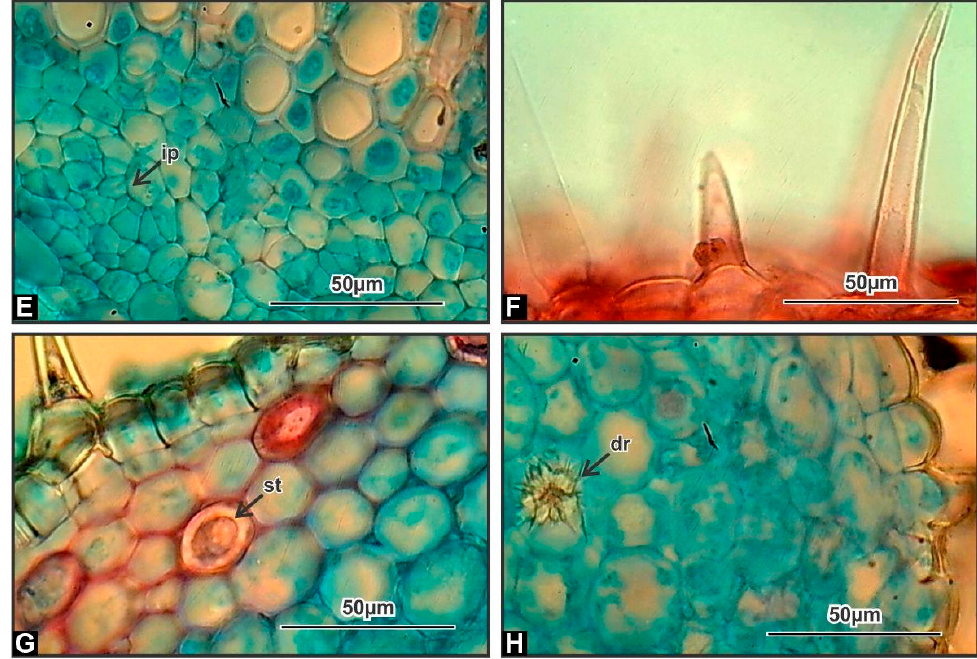
Figure 1. Anatomy of Kopsia fruticosa Roxb. stem: ( A ) TS of the stem through the node (foliar apex); ( B – D ) TS of the young stem from sub-apical toward the lower portion at distinct levels showing the development of secondary growth; ( E ) magnified portion exhibits intraxylary phloem; ( F ) magnified image exhibits unicellular hairs; ( G ) magnified image exhibits the stone cells in collenchymatous region; ( H ) magnified image exhibits the druses crystal (a type of calcium oxalate crystal) in pith region; ip—intraxylary phloem; dr—druses; st—stone cell.